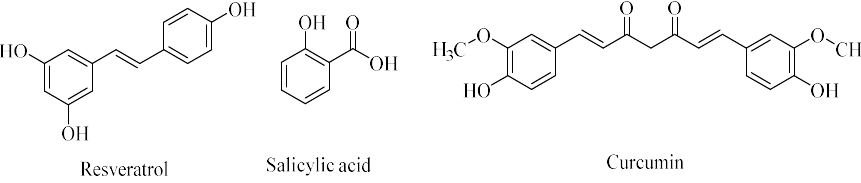
Figure 1. Structures of some of the naturally occurring polyphenolic compounds.